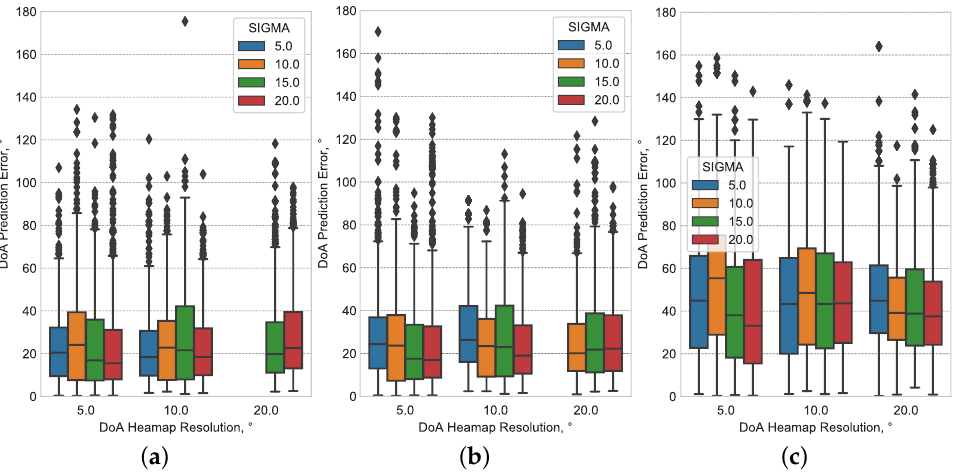
Figure 4. Angular errors of three sources DoA estimation using our method (( a ) STFT not permuted; ( b ) STFT with permuted time and frequency dimensions; ( c ) GCCPHAT); data were unavailable for the CNN trained on STFT features with permuted time and frequency dimensions with σ ∈ [ 5,10 ] and CNN trained on regular STFT features with σ =